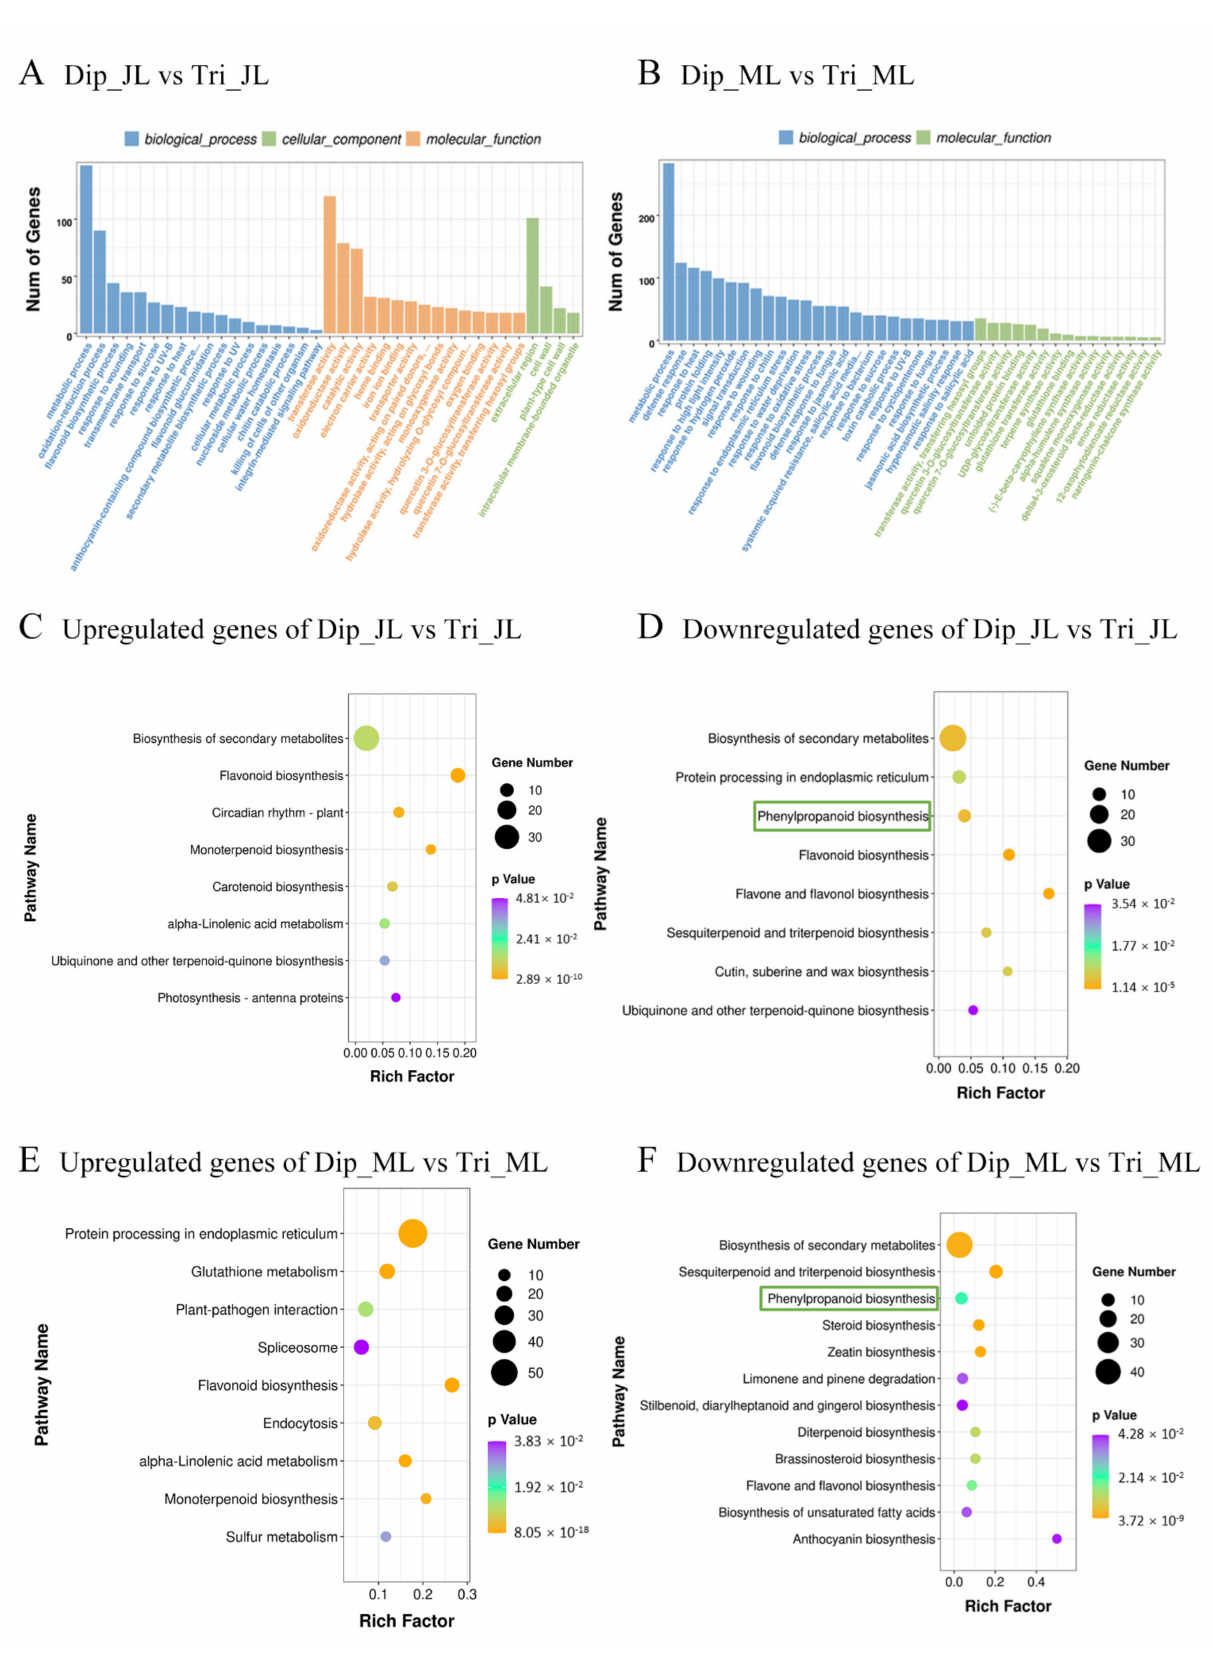
Figure 3. Functional enrichment analysis of differentially expressed genes (DEGs). ( A ) Gene Ontology (GO) analysis of DEGs between juvenile triploid and diploid leaves. ( B ) GO analysis of DEGs